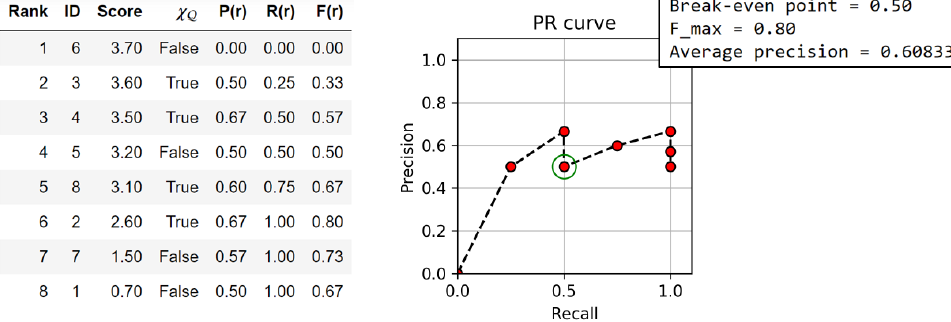
Figure 20. Evaluation metrics from the FMP Notebook Evaluation Measures applied to a toy